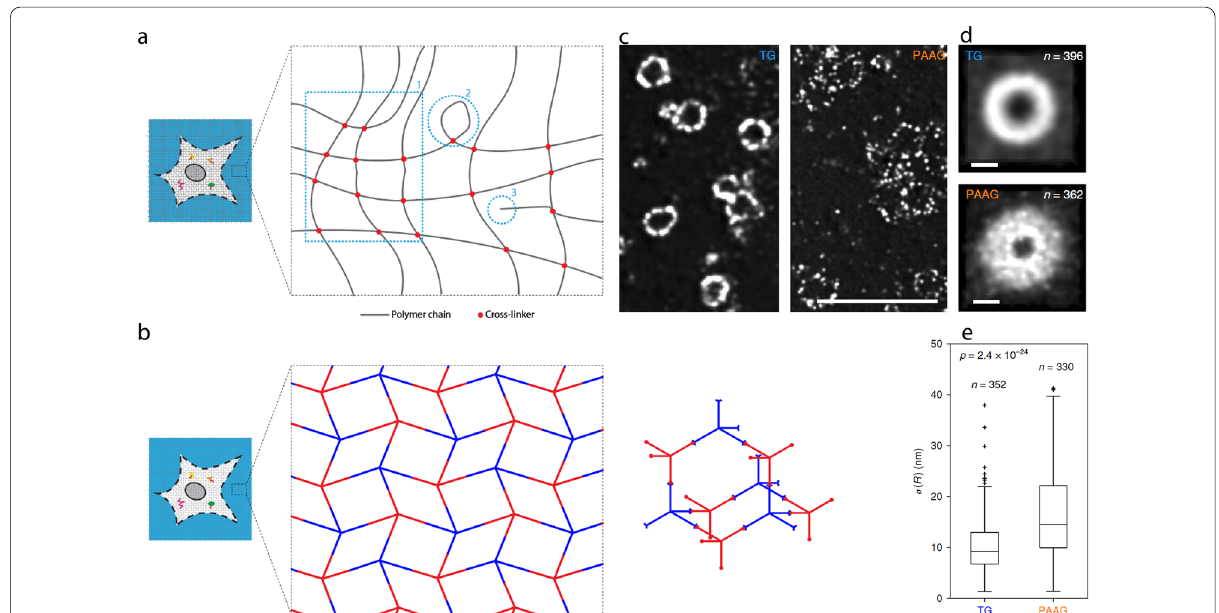
Fig. 17 Chemical design and imaging validation of tetra-gel (TG)-ExM for high-isotropy expansion. a Possible structural defects of hydrogels synthesized via free-radical chain-growth polymerization. b Chemical components of TG. c HSV-1 virions with directly labelled envelope proteins, expanded by TG- (left) and PAAG-based (right) two-round iterative expansion. Scale bar (for both panels), 1 μm (TG, 10.3 μm; PAAG, 15.3 μm). d Single-particle averaged images of HSV-1 virions after TG- (top) and PAAG-based (bottom) two-round iterative expansion (TG, n 396; PAAG, = n 362 virions). Scale bars, 100 nm. e Standard deviation ( σ ) of HSV-1 virion radius ( R ) within individual virions for TG- and PAAG-based iterative = expansion ( p 2.4 10 − 24 , two-sided Wilcoxon rank sum test; TG, n 352; PAAG, n 330 virions). ( c – e Reprinted/adapted by permission from = × = = Springer Nature: Gao et al. [54], copyright